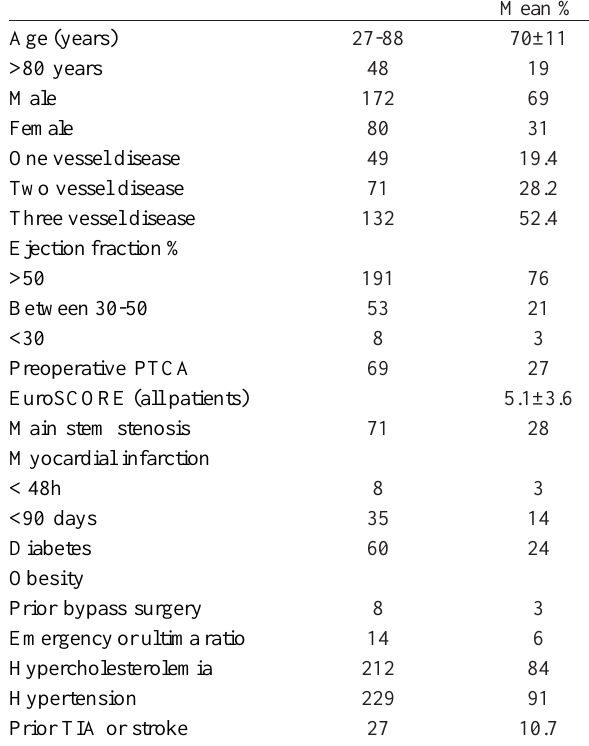
Table 1. Preoperative patients’